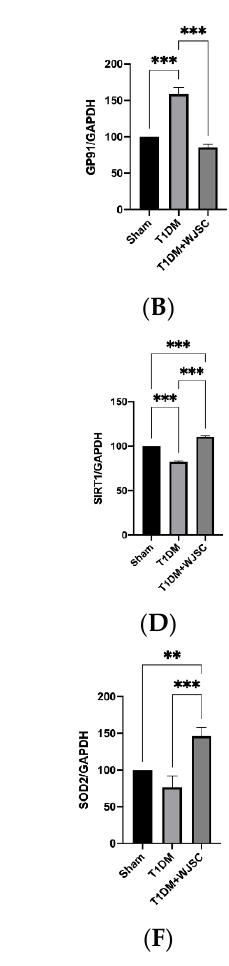
Figure 4. Exploring oxidative stress related markers for heart tissues using western blotting analysis.